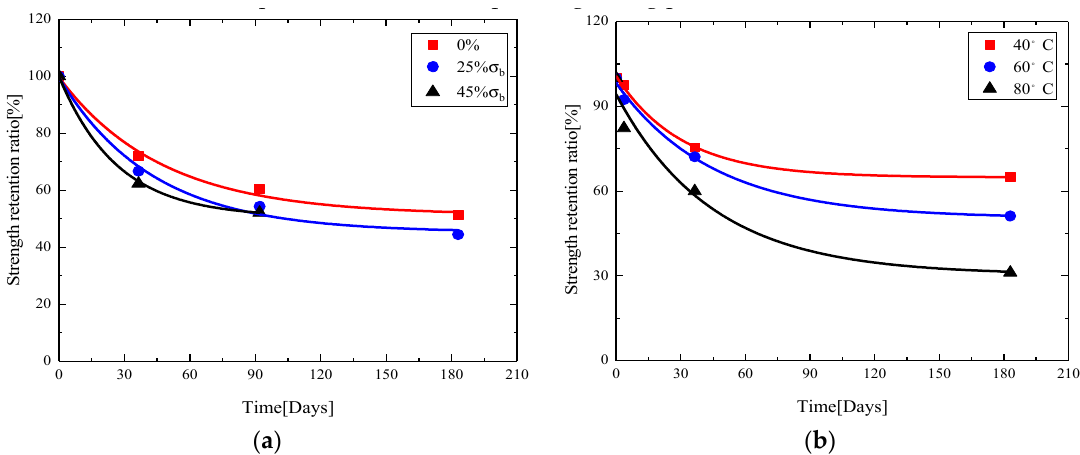
Figure 8. Fitting of modified model with experimental data of: ( a ) the results in [20]; and ( b ) the results in [25]. Table 4. Fitting equation coefficient of modified model with experimental values in [20,25].